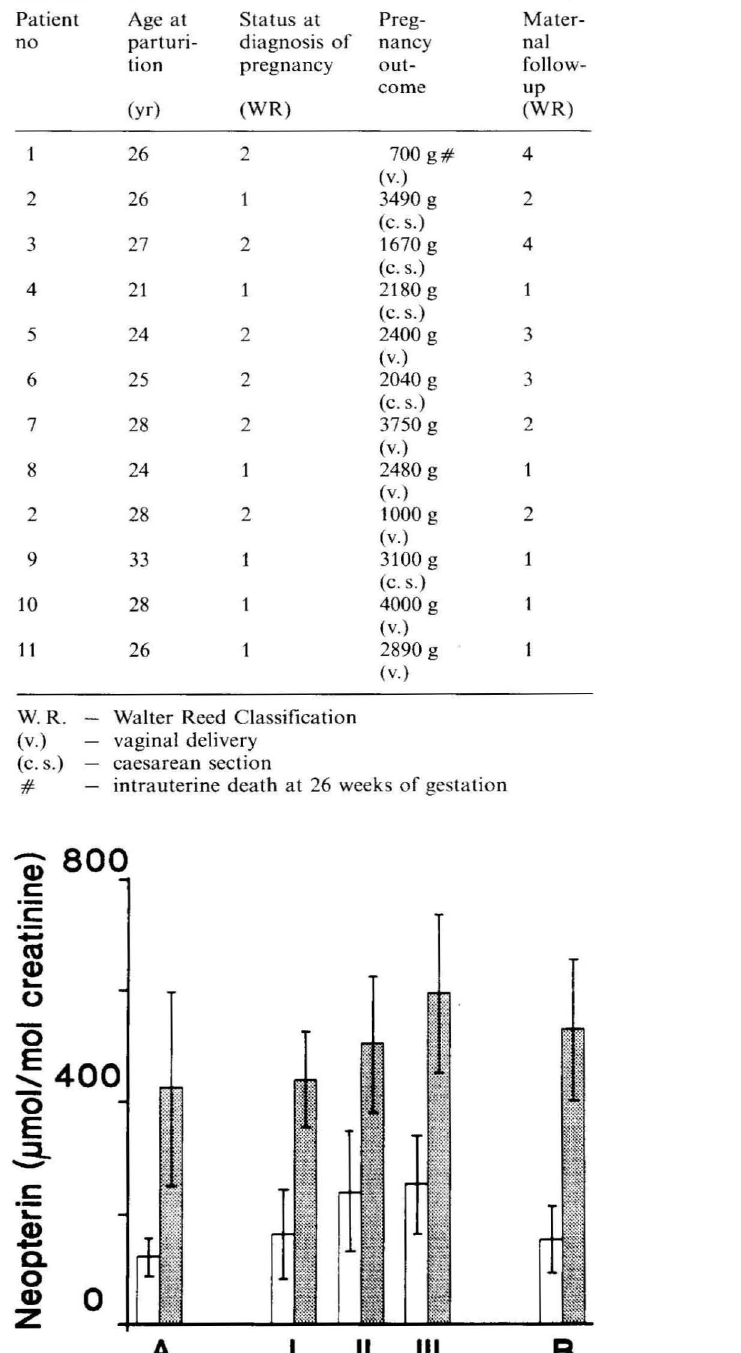
Table 1. Demographic and clinical data of HIV -1 positive preg nant women.